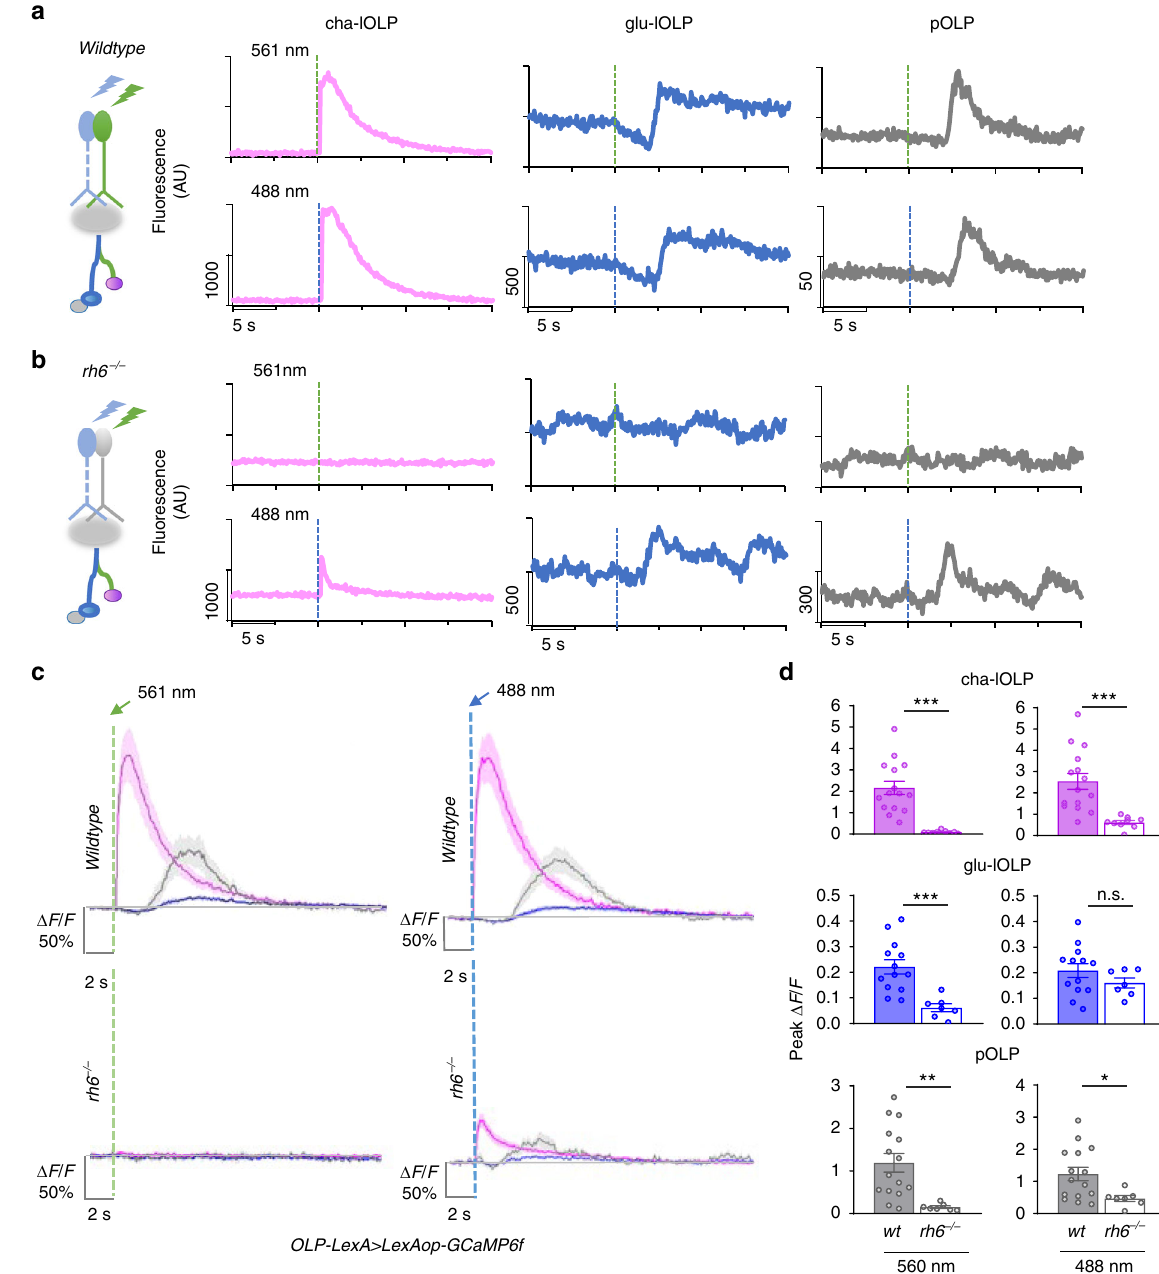
Fig. 2 OLPs receive presynaptic inputs predominantly from Rh6-PRs. a , b The contribution of Rh5- and Rh6-PRs to light-evoked calcium responses in OLPs as revealed by stimulation at different wavelengths in wild-type and Rh6 mutants. Left: schematic diagram illustrating the stimulation scheme used in calcium imaging experiments. Green or blue light pulses (dashed lines, green: 561 nm, blue: 488 nm) activate Rh5- or Rh6-PRs and elicit OLP-LexA-driven GCaMP6f signals in the somas of OLPs. Right: Representative raw traces of OLP > GCaMP6f collected from wild-type and Rh6 mutants ( rh6 − / − ). Magenta: cha-lOLP; blue: glu-lOLP; gray: pOLP. c , d OLPs are functionally connected to Rh6-PRs in the third instar larval brain. Light pulses (dashed lines, green: 561 nm, blue: 488 nm) induced fast calcium transients in cha-lOLP (magenta) and slow transients in glu-lOLP (blue) and pOLP (gray). Compared to wild- type controls, OLPs in Rh6 mutants showed no response towards green light (561 nm) stimulation and dampened responses toward blue light (488 nm) stimulation except for glu-lOLP, which remained equally responsive. The c average traces and d quanti fi cation of peak value of changed intensity ( Δ F / F ) are shown. Shaded areas on traces and error bars on quanti fi cations represent SEM. Wild-type control: cha-lOLP, n = 15; glu-lOLP, n = 13; pOLP, n = 15. Rh6 mutant ( rh6 − / − ): cha-lOLP, n = 9; glu-lOLP, n = 7; pOLP, n = 7. cha-OLP, 561 nm: p < 0.0001, t = 5.102, df = 22; cha-OLP, 488 nm: p = 0.0007, t = 3.929, df = 22; glu-OLP, 561 nm: p = 0.0009, t = 3.977, df = 18; glu-OLP, 488 nm: p = 0.2362, t = 1.225, df = 18; pOLP, 561 nm: p = 0.0044, t = 3.207, df = 20; pOLP, 488 nm: p = 0.0261, t = 2.402, df = 20. Statistical signi fi cance was determined by Student ’ s t test. p ≥ 0.05 was considered not signi fi cant (n.s.), *** p < 0.001, ** p < 0.01, and * p <